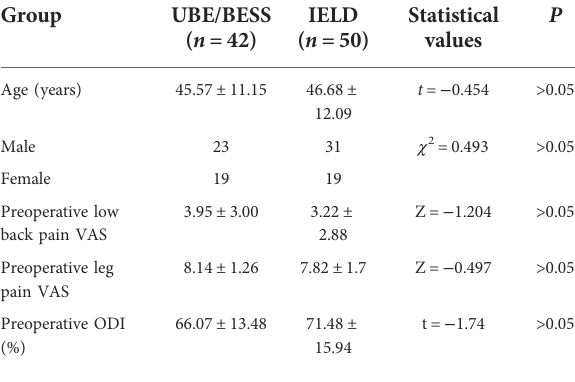
TABLE 3 Comparison of clinical outcomes of UBE/BESS and IELD. TABLE 1 Baseline information of UBE/BESS and